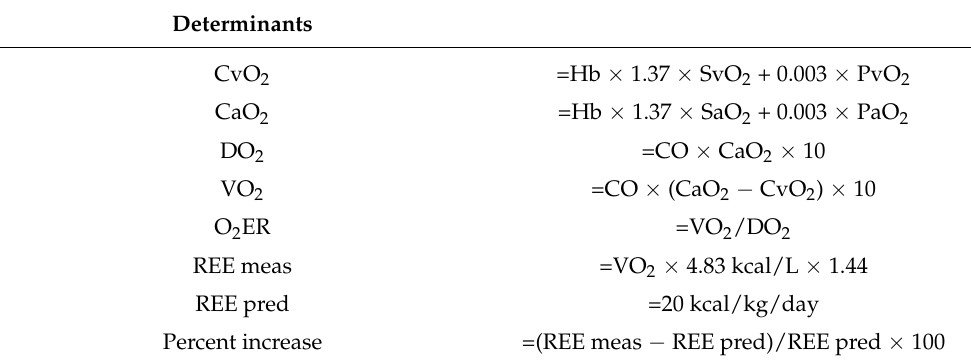
Table 1. The determinants of venous and arterial oxygen content, oxygen delivery, oxygen consump- tion, oxygen extraction and resting energy